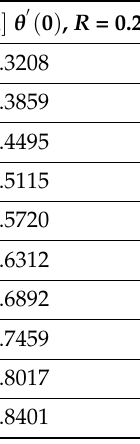
Table 9. Influence of heat generation parameter on Nusselt